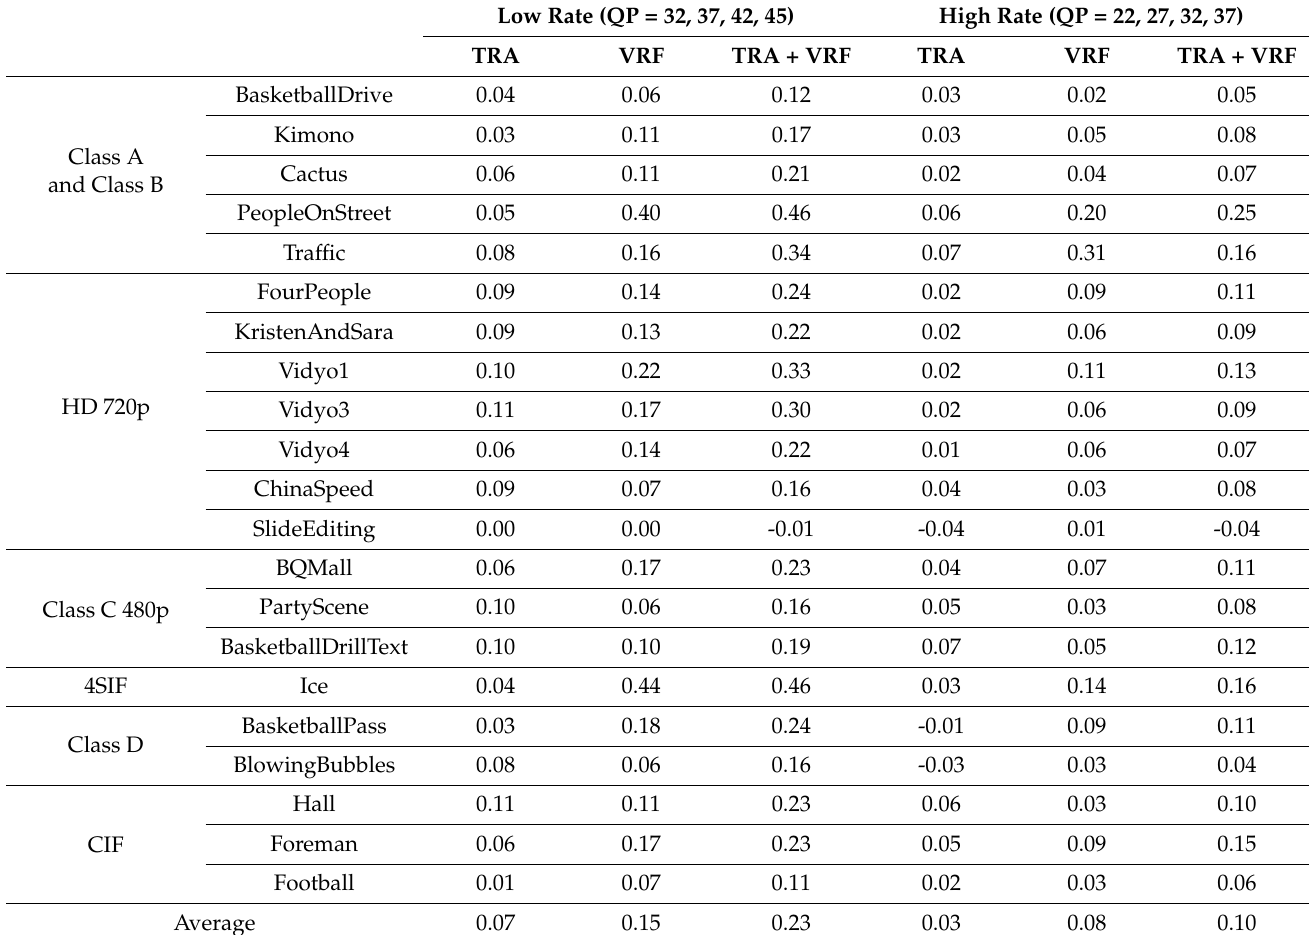
Table 4. Y-BDPSNR (dB) coding performance of various methods for test sequences, full frames.